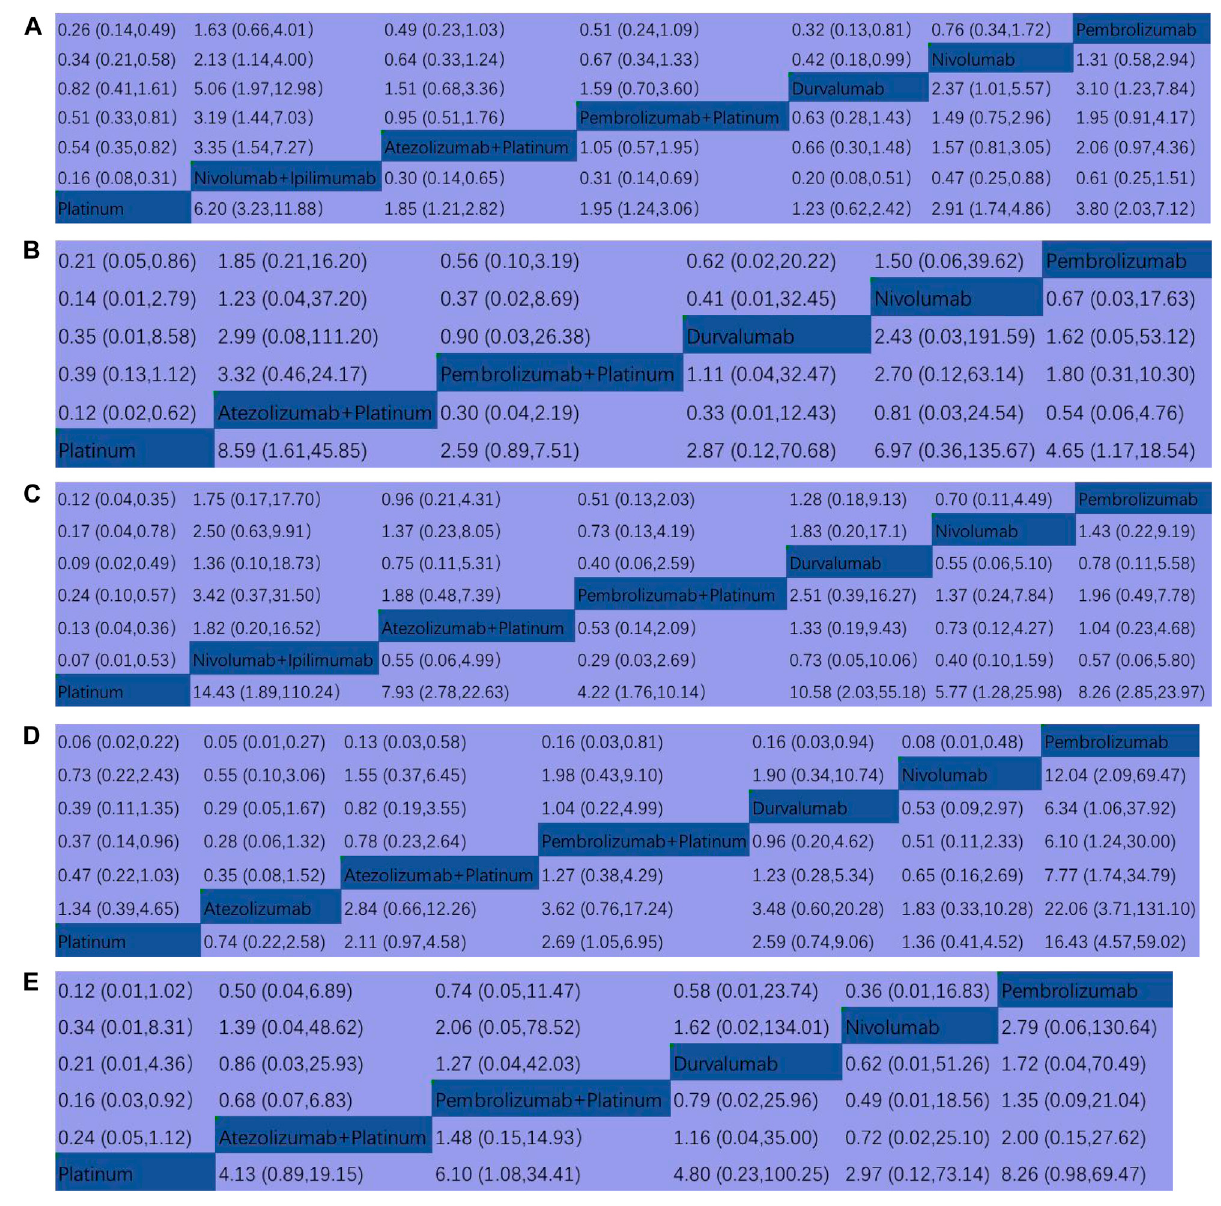
Frontiers in Pharmacology |